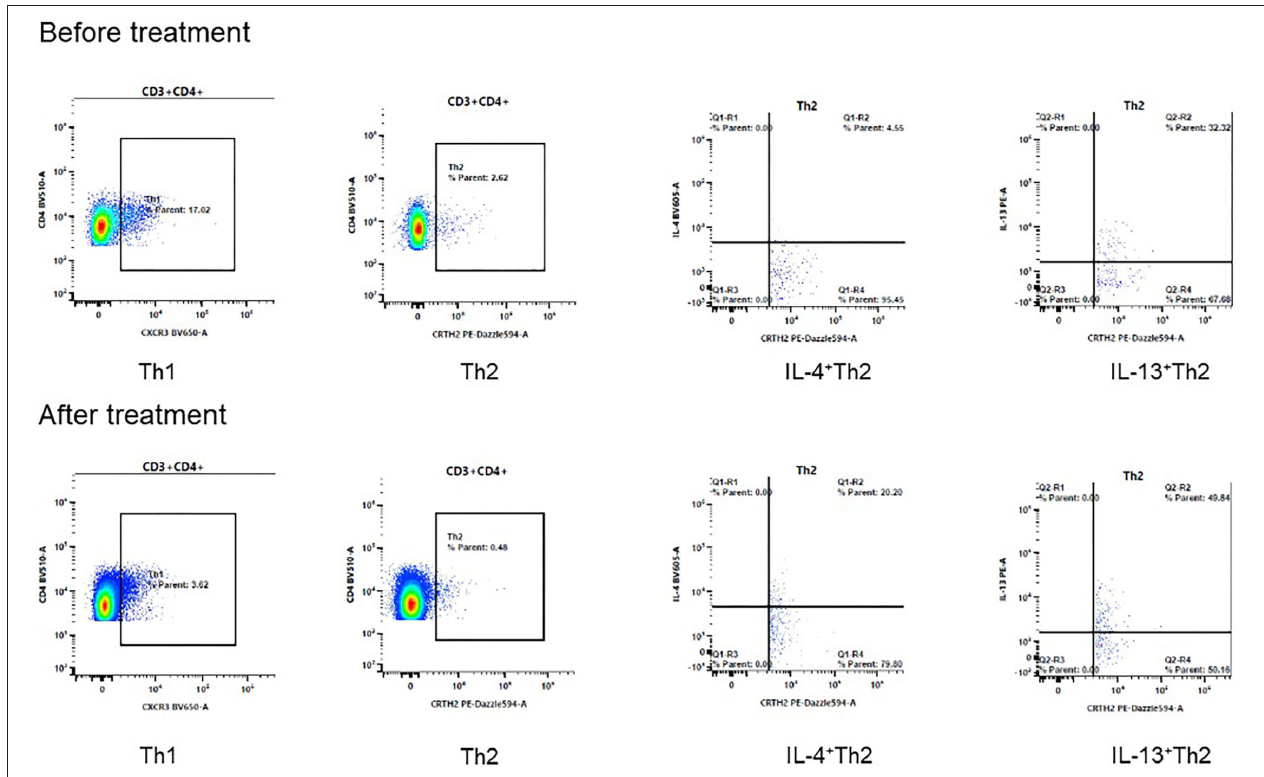
FIGURE 1 | The changes of Th1 and Th2 cells after 8 weeks treatment of Dupilumab. The proportion of IL-4+Th2 cells increased from 4.55% to 20.20%, IL-13+Th2 cells increased from 32.32% to 49.84% after treatment in patient #2.